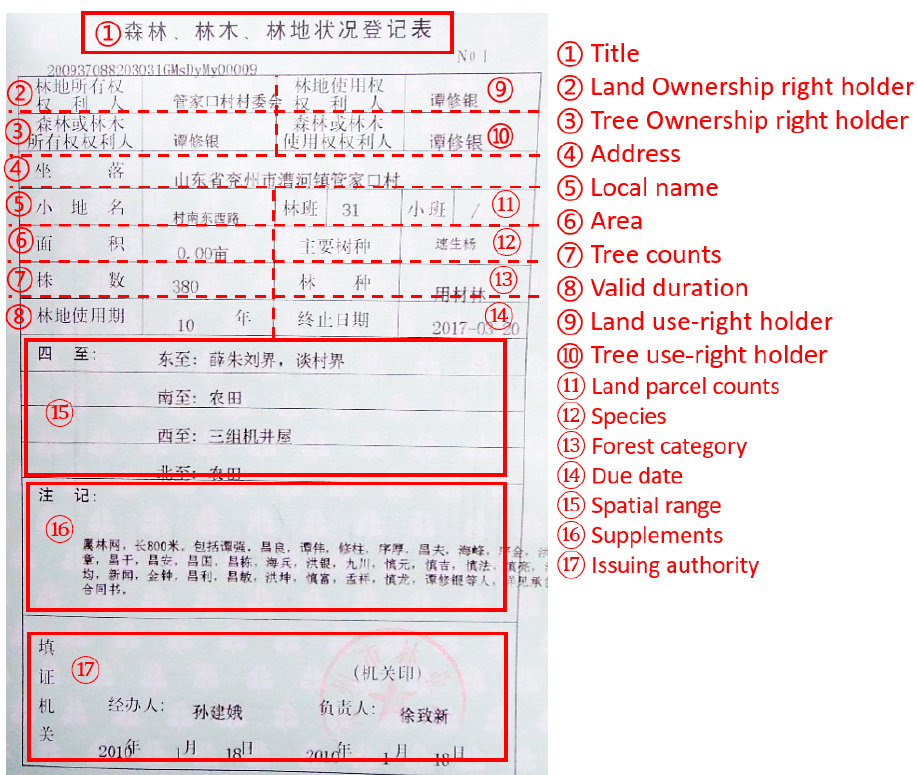
Figure 7. Certificate of forest rights from the People’s Republic of China (source: https://pic17.9977 88.com/_pic_search/00/03/14/20/3142062b.jpg, accessed on 26 October 2021).